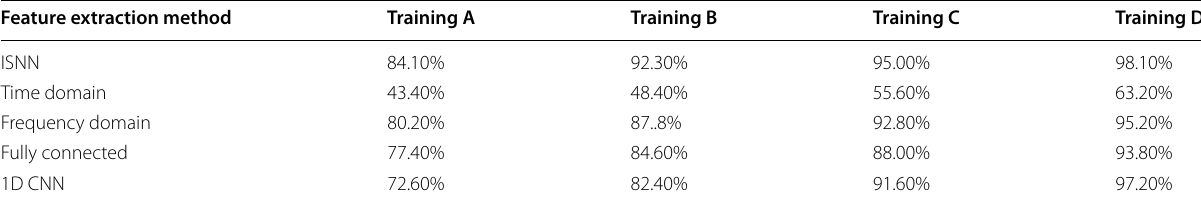
Table 3 Accuracy of different feature extraction methods Feature extraction